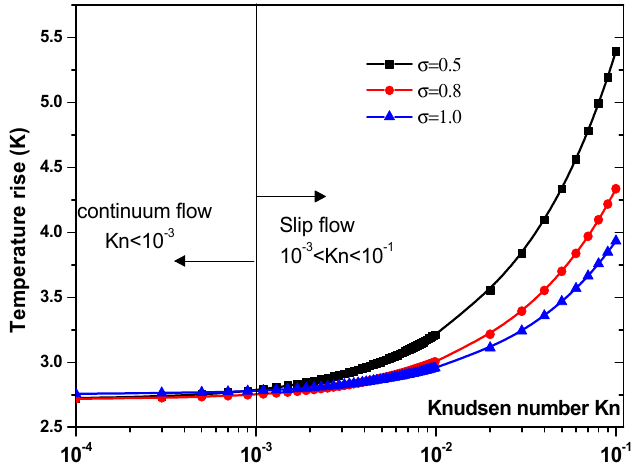
Figure 8. Temperature rise versus the Knudsen number for second structure at V rms = 15 V.